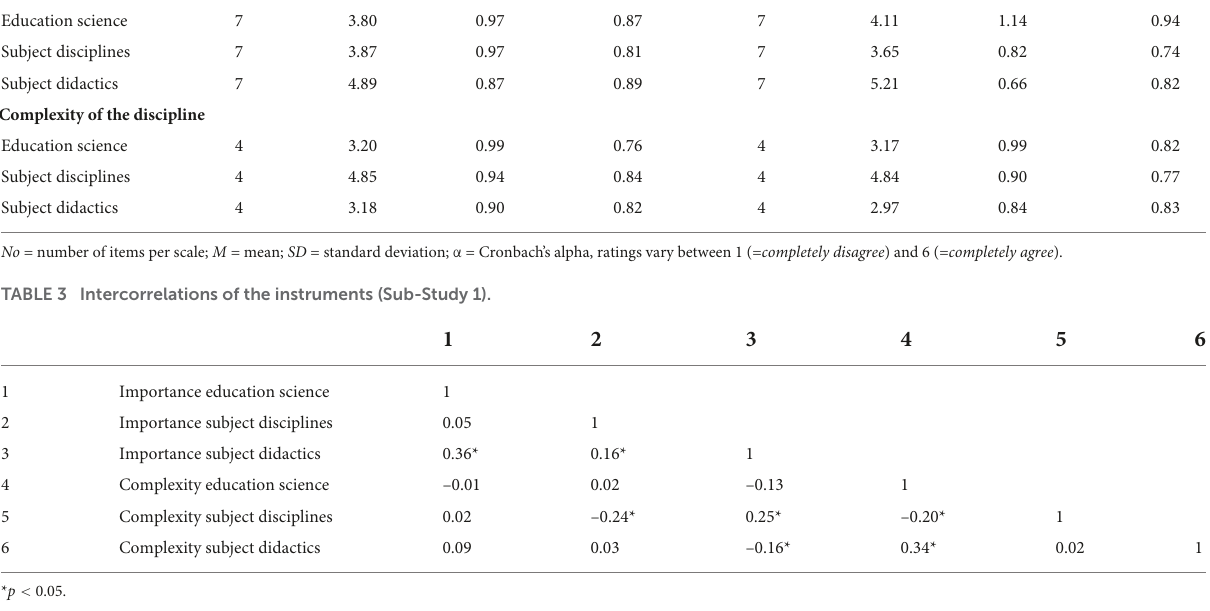
( Figure 1 ). In contrast, the difference for subject disciplines by degree program ( p = 0.992) was not statistically